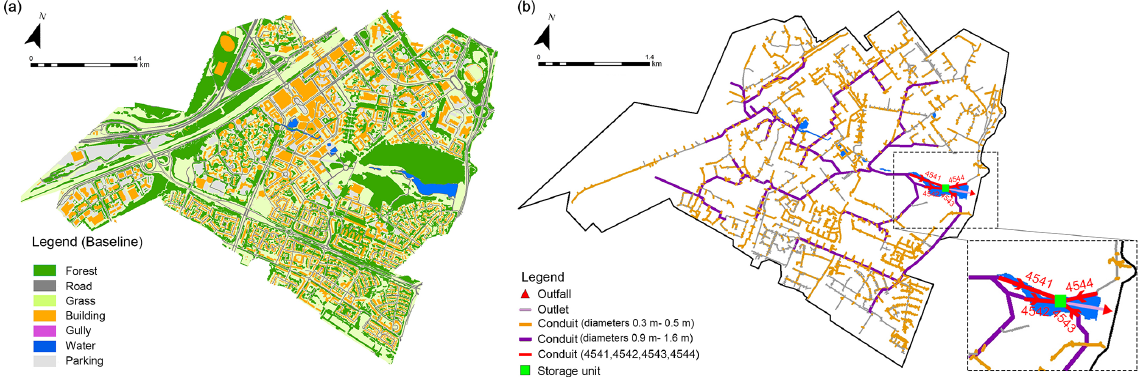
Figure 2. (a) Land use map (baseline scenario). (b) Drainage system with four conduits (4541, 4542, 4543, and 4544)